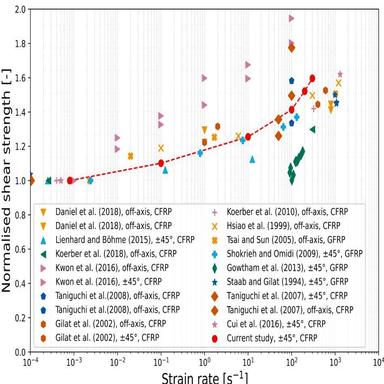
Comparison of published experimental results on in-plane shear strength,50–56] with the values obtained from the current study.